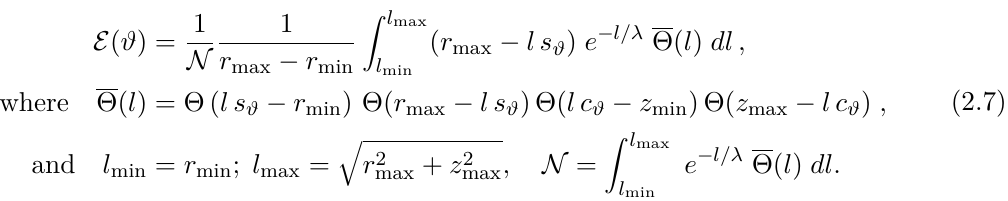
Figure 1 . We plot, using solid black lines, the vertex reconstruction efficiency distributions as a function of ϑ for two different characteristic decay lengths, λ = 0 . 5 m (left panel) and λ = 1 . 3 m (right panel). Using red dashed lines, we plot the ‘fake’ efficiency distribution that assumes all the outgoing particles decay at a distance equal to the characteristic decay length of the particle, i.e., assuming a Dirac-delta decay distribution in place of the exponentially falling decay distribution. We also indicate, using dashed lines, the geometric cuts on the angular distribution, as imposed in our